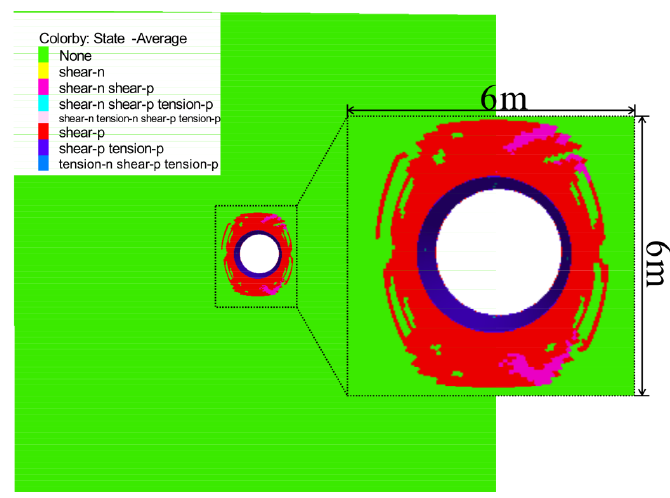
Figure 21. The surrounding rock’s plastic zone distribution under the new support scheme.